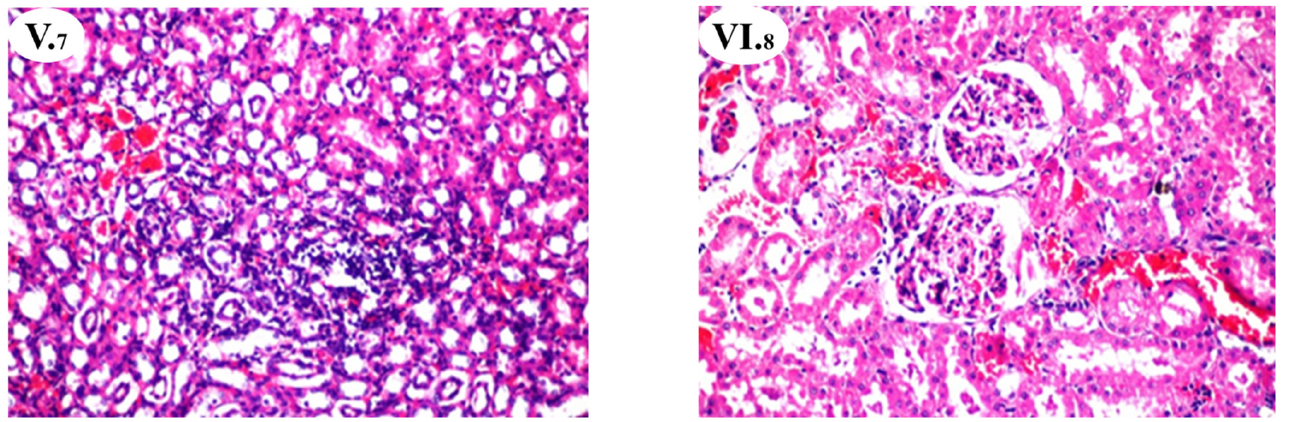
Figure 1. Histopathological findings of rat kidney protection by A. hierochuntica extracts (Hematoxylin-Eosin (HE), 200X). Histopathological nephrotoxicity induction. GI: Histopathological structure of control group with normal histological structure of the glomeruli and tubules of rat kidney ( I. 1 ). GII: Kidney of a rat receiving only CCl 4 showing focal inflammatory cell infiltration in between the tubules at the cortex ( II. 2 ). There was congestion in the blood vessels between the tubules, and multiple eosinophilic casts formed in the lumen of some tubules at the cortex. The corticomedullary portion showed focal hemorrhage and hemolysis in between the degenerated tubules ( II. 3 ). GIII: Kidney of a rat receiving CCl 4 + vit. E + Se showing congestion in the blood vessels in between the tubules at the cortex ( III. 4 ). GIV: Kidney of a rat receiving CCl 4 + KEE viewing congestion in the cortical blood vessels ( IV. 5 ). GV: rat kidney receiving CCl 4 + KAE showing congestion in the cortical blood vessels ( V. 6 ). The corticomedullary junction showed focal inflammatory cells infiltration with eosinophilic renal casts formation in the lumen of some tubules ( V. 7 ). GVI: kidney of rats receiving CCl 4 + KEE + KAE showing congestion in the cortical blood vessels and glomeruli ( VI. 8 ).